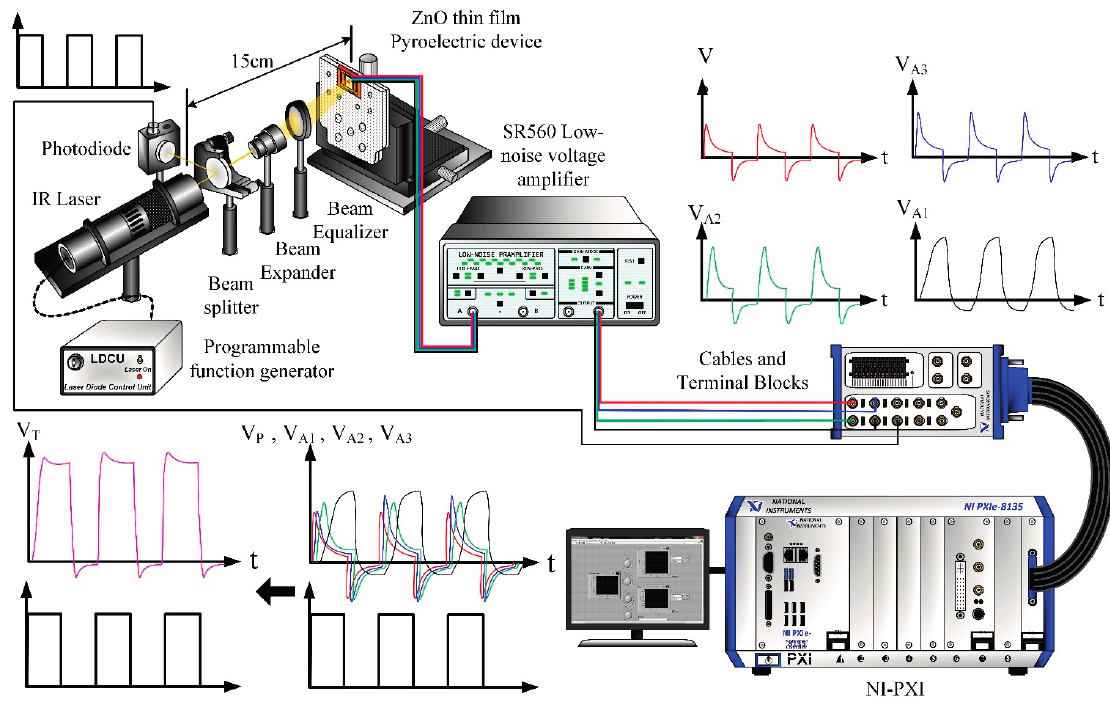
Figure 6. Schematic diagram for voltage responsivity measurement